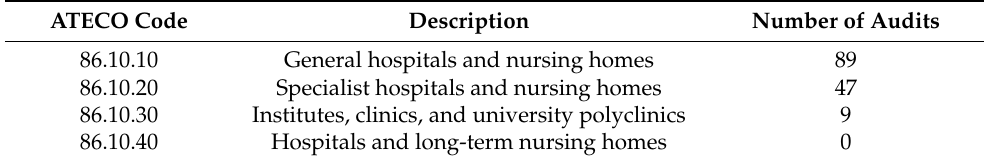
Table 1. The number of audits for each subcategory of ATECO